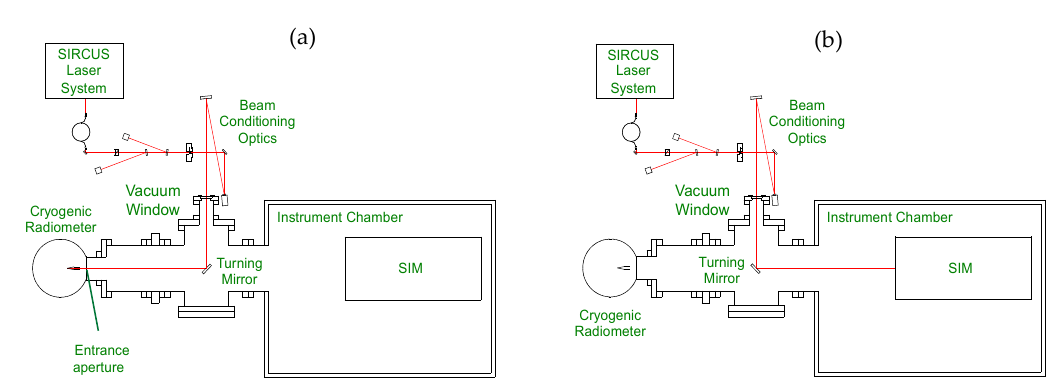
Figure 2. Overview of the Laboratory for Atmospheric and Space Physics (LASP) Spectral Radiometer Facility (SRF) showing the cryogenic radiometer irradiance (a) and the SIM irradiance (b) measurement configuration. After laser stability and conditioning optics, the light passes through a common vacuum window into a common vacuum instrument chamber. A single, high rotational precision 45° reflection mirror directs the laser into the cryogenic radiometer (CR) or SIM path. For this measurement, the laser was both frequency and intensity stabilized (<0.05% rms variability).